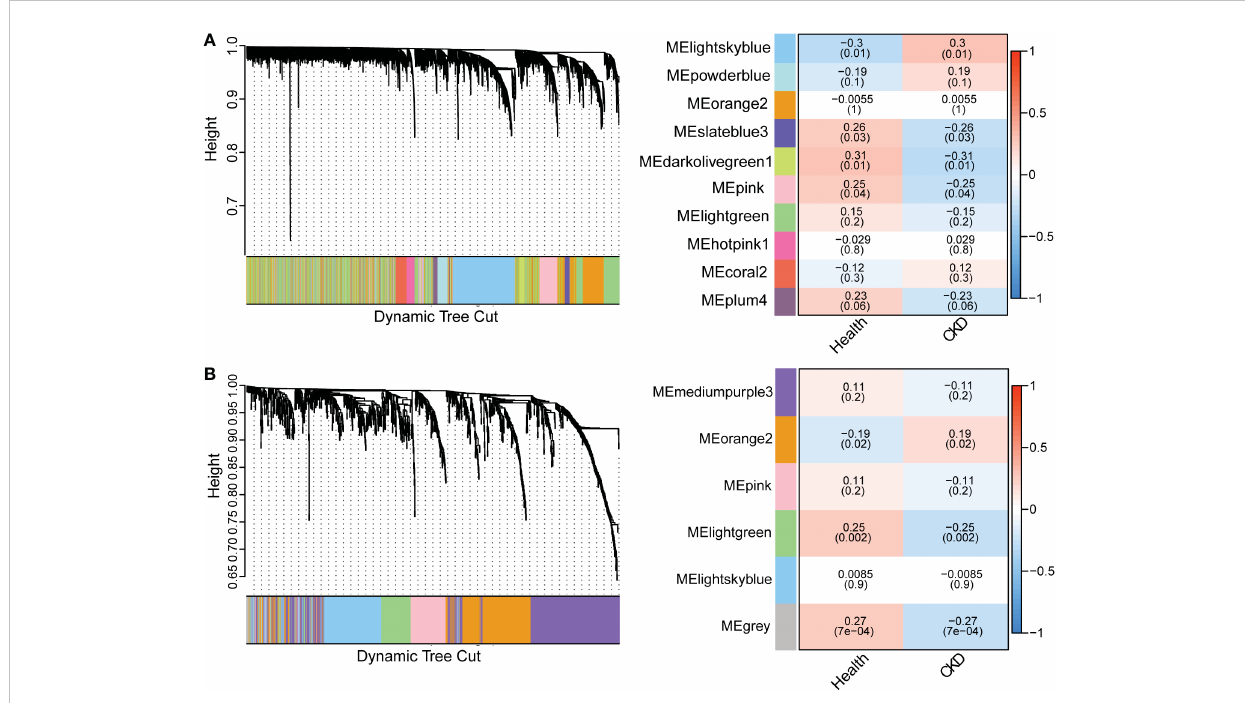
FIGURE 4 Weighted gene co-expression network analysis (WGCNA) revealing gene co-expression networks in samples from CKD patients (A) WGCNA analysis of PBMC samples. The left dendrogram represented the clusters of differentially expressed genes based on different metrics. Each branch represented one gene, and each color below branches represented one co-expression module. The right heatmap showed the correlation between gene modules and CKD. The correlation coef fi cient in each cube represented the correlation between gene modules and traits, which decreased from red to blue. (B) WGCNA analysis of TISSUE